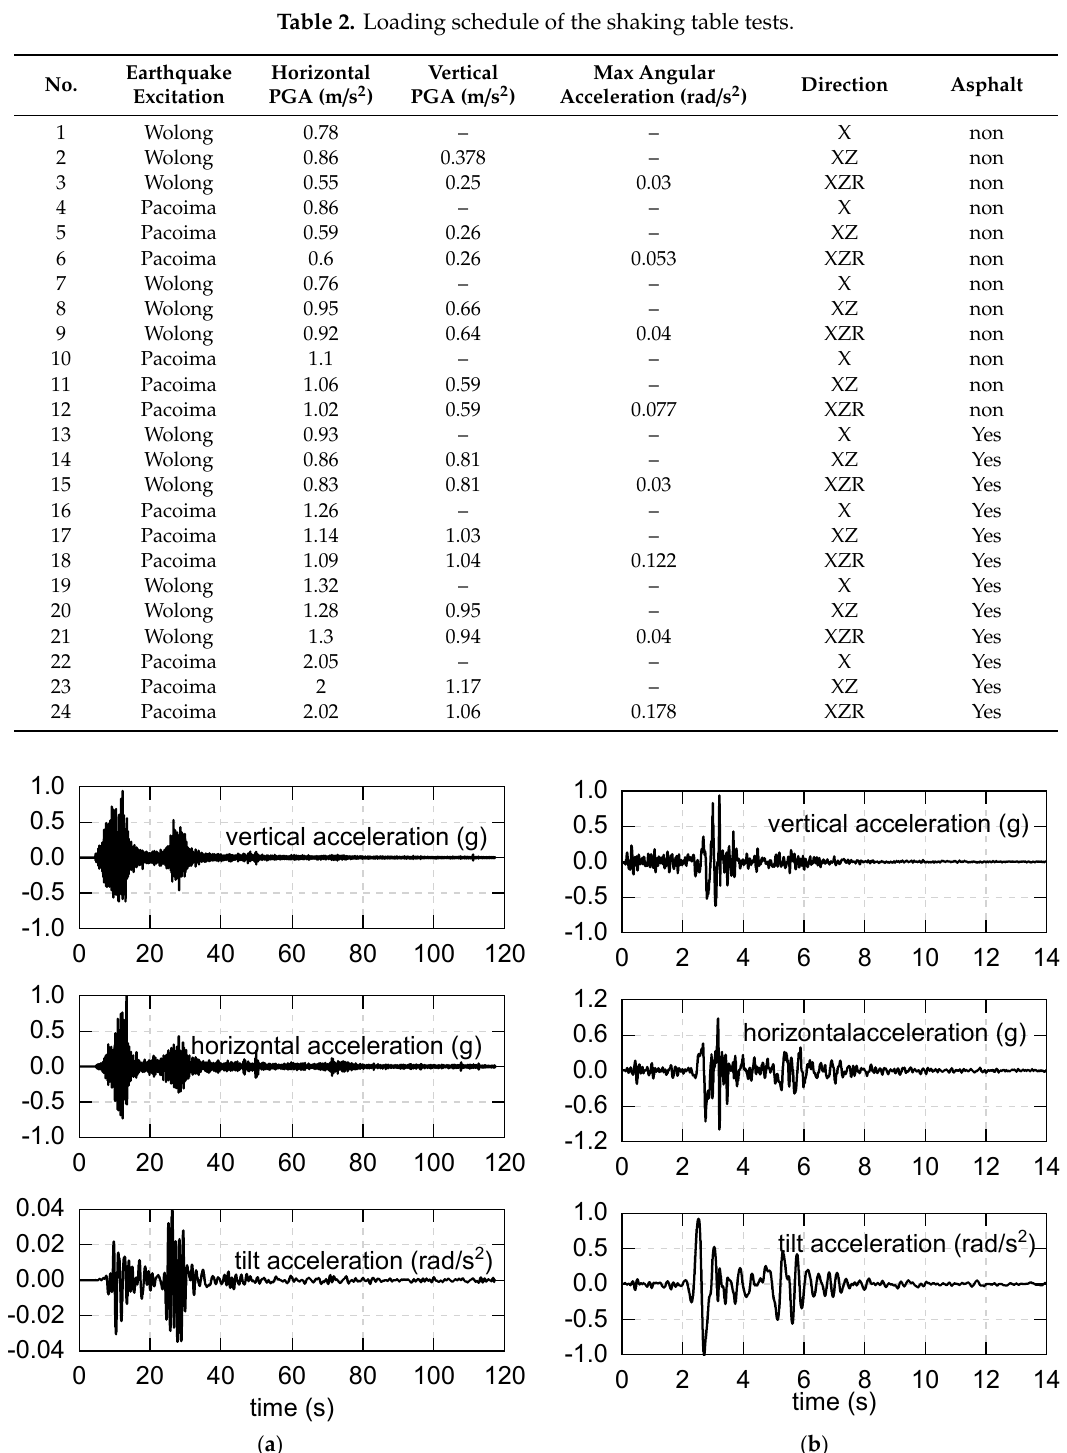
Figure 14. Time histories of the adopted ground motions: ( a ) Wolong wave; ( b ) Pacoima wave.